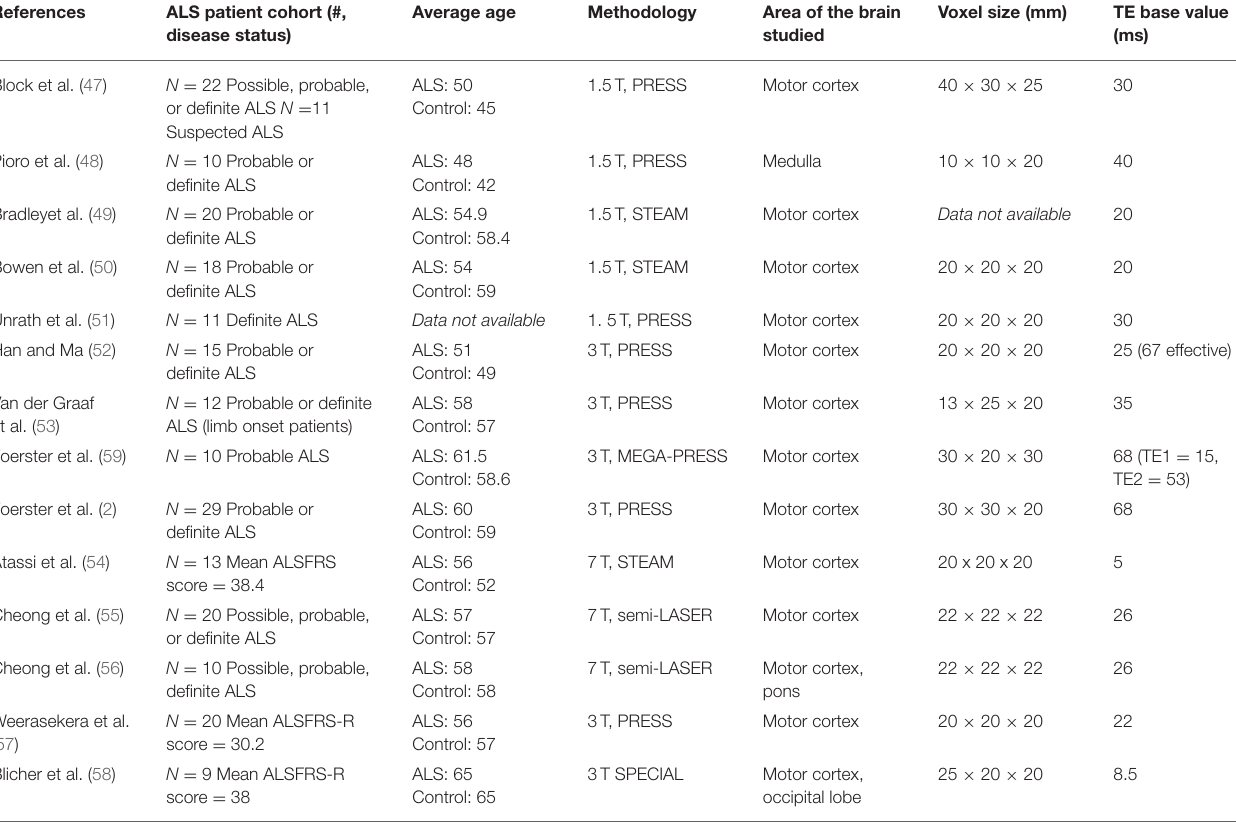
TABLE 4 | Methodology overview of all 1 H-MRS studies evaluated.